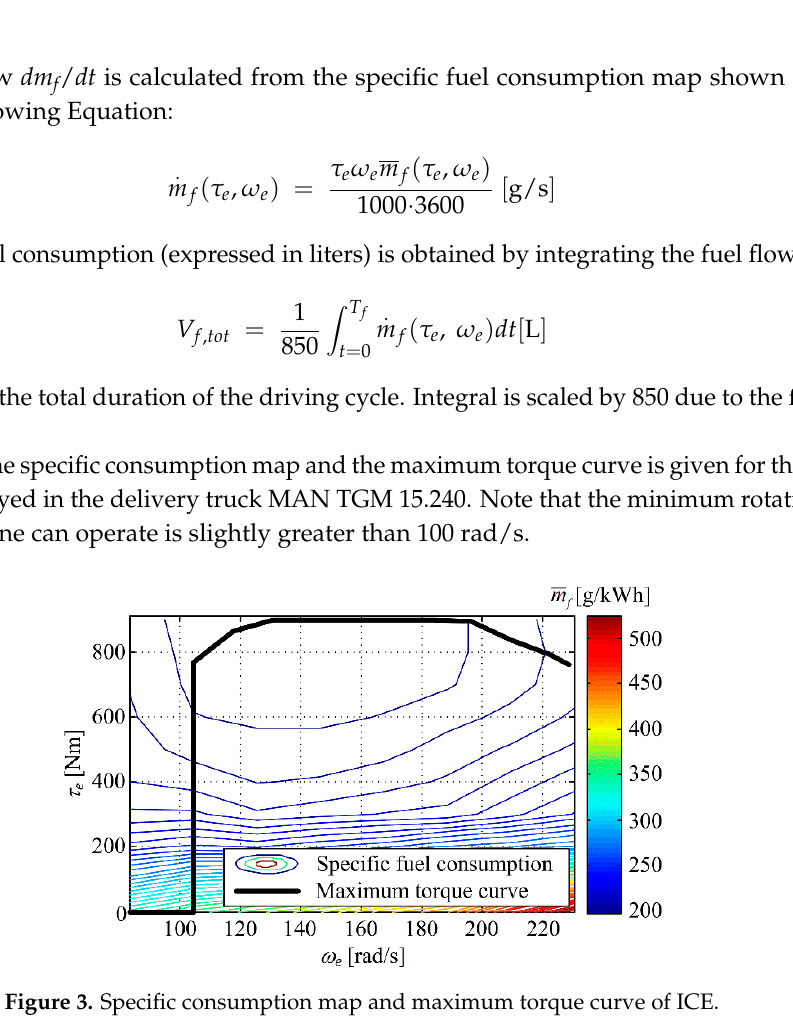
Figure 4. Hybrid hydraulic vehicle (HHV) in parallel configuration.